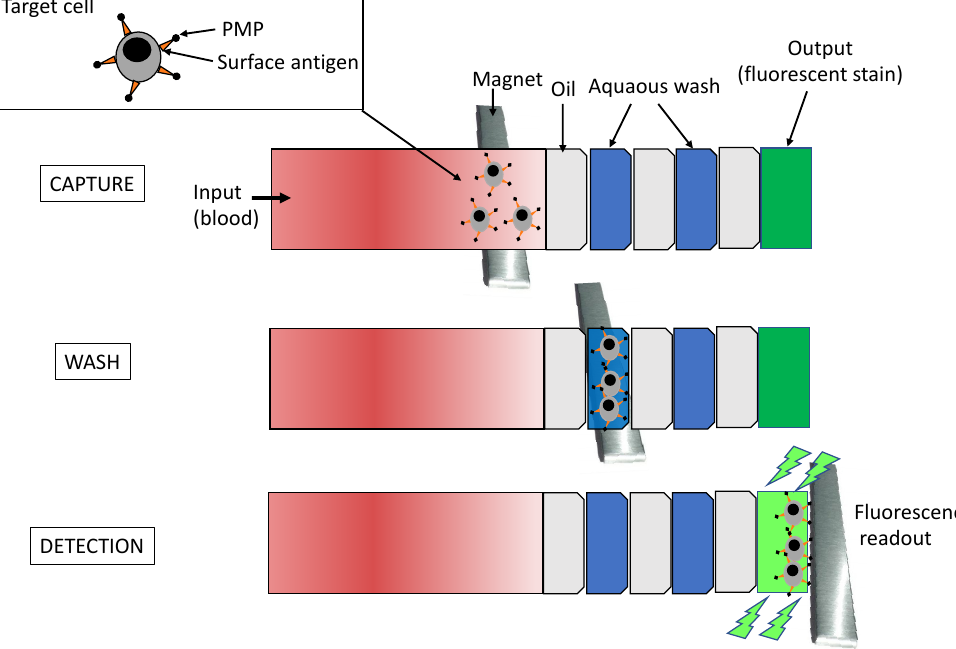
Figure 7. Schematic representation of the IFAST device. It is formed by seven successive flow chambers containing three oil barriers. The magnet at the bottom of the device is moved from the input to the output wells at a rate of 1–2 mm per second. The paramagnetic particles (PMP) move with the magnet, carrying along attached cells and excluding unbound cells at the immiscible phase barrier. Isolated cells are dyed on-chip with a small molecule dye (Calcein AM) metabolized to a fluorophore to be read by a fluorometer